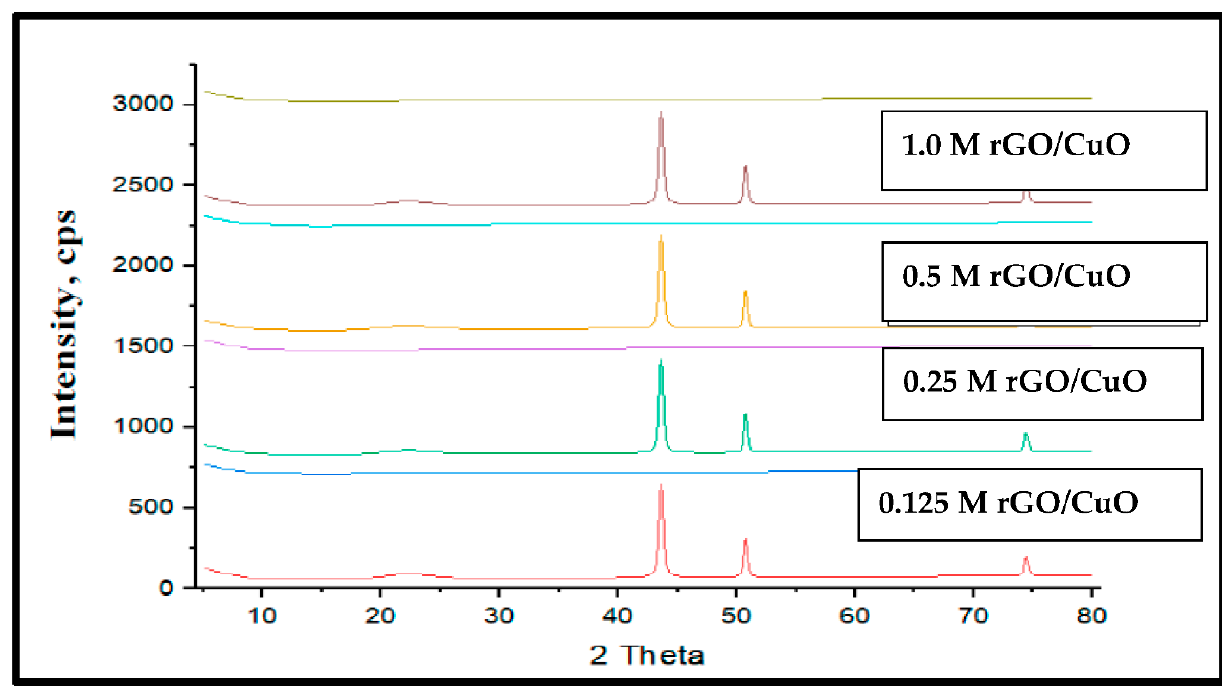
Figure 5. XRD patterns of pure CuO and rGO/CuO composites at different rGO molarity concen-